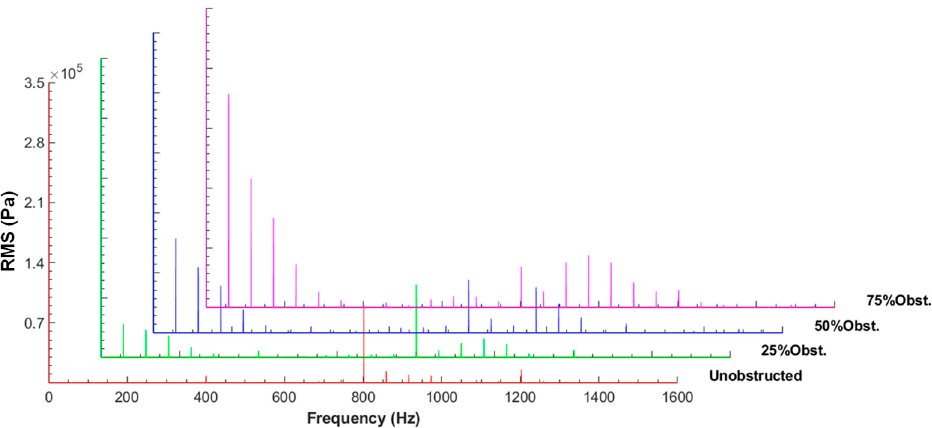
Figure 14. Frequency spectra in the inertial reference frame (monitor point E2) for different rotor blockage sizes.